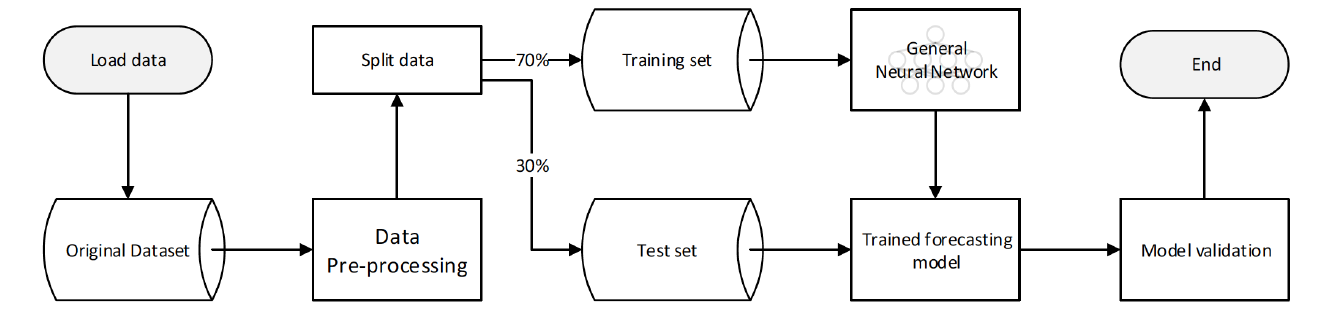
Figure 3. Diagram of the first approach according to the general model where there is only one neural network that learns from energy consumption data and will be outputting the next